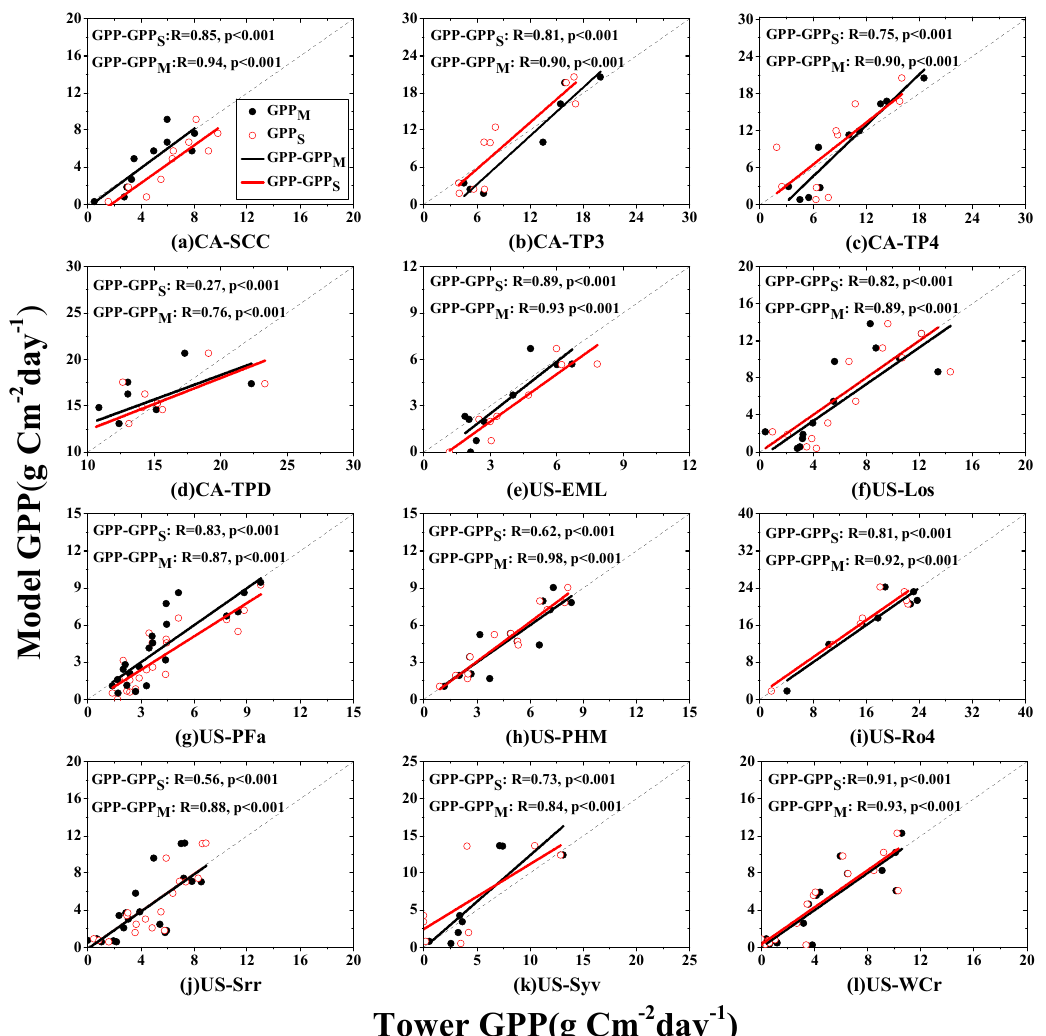
Figure 5. Validation of the SIF-GPP model and the SIF-CO 2 -GPP model for different EC flux towers. The black dots represent the GPP estimated by the SIF-CO 2 -GPP model, and the red circles represent the GPP estimated by the SIF-GPP model. The fit lines for GPP of the flux towers and GPP M are indicated by black lines. Fitting lines for GPP for flux towers and GPP S are indicated by red lines